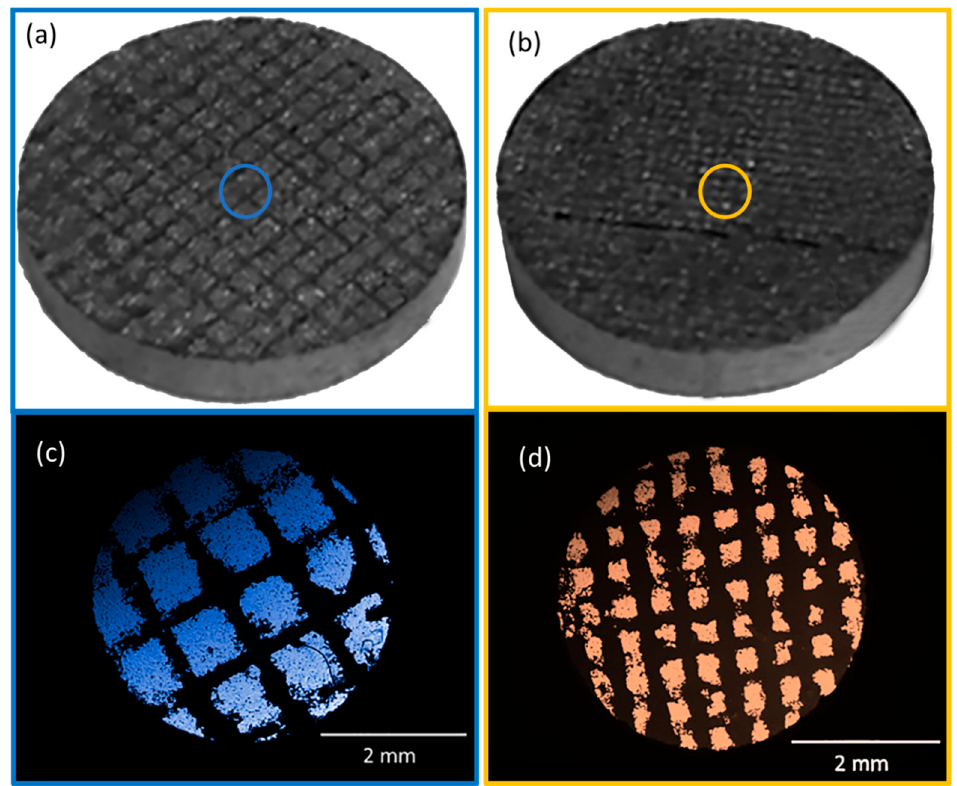
Figure 3. Ti substrate printed with a ( a ) 1 mm 2 and ( b ) 0.5 mm 2 grid, and SEM micrographs of the ( c ) 1 mm 2 and ( d ) 0.5 mm 2 grid.